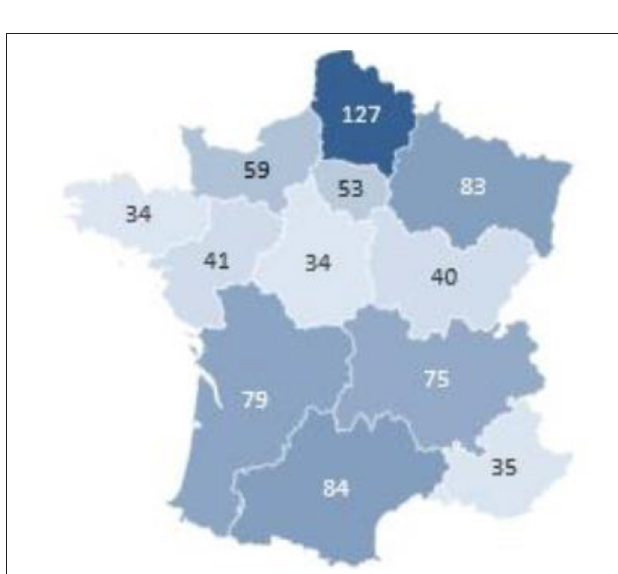
FIGURE 4 | Geographical distribution of